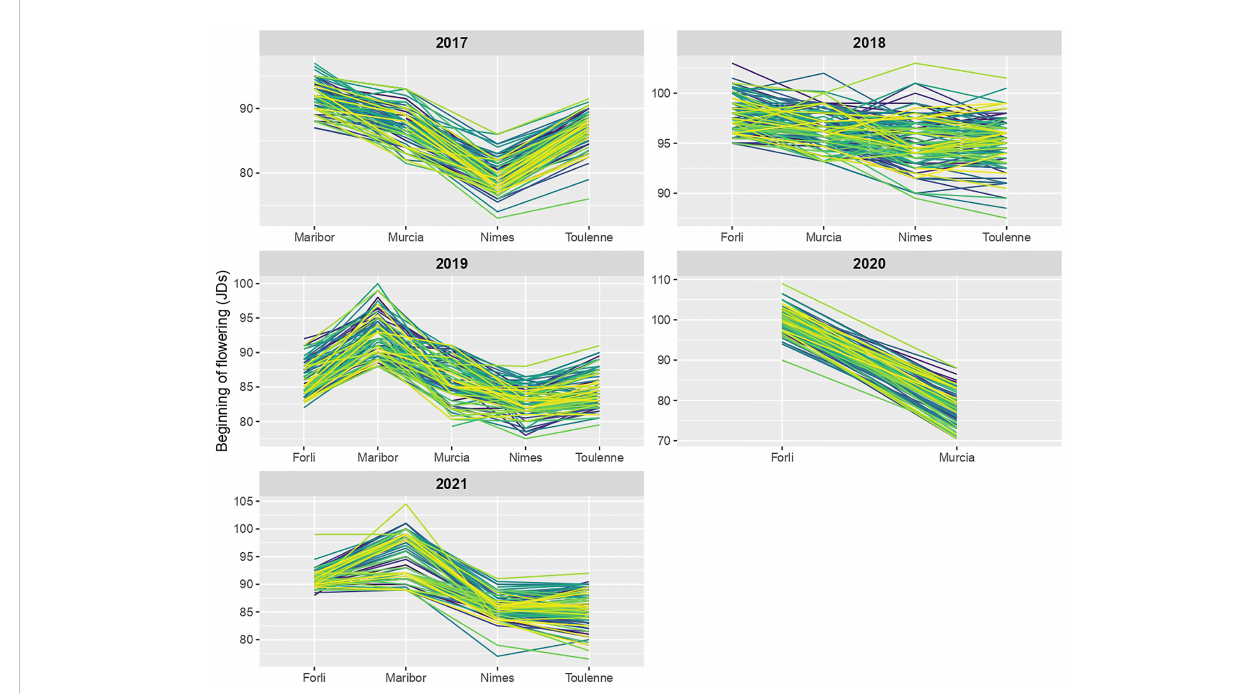
FIGURE 5 Reaction norms for beginning of fl owering (BF) across locations in each year of study. Norm of reaction of each R×L hybrid is shown by a colored line.